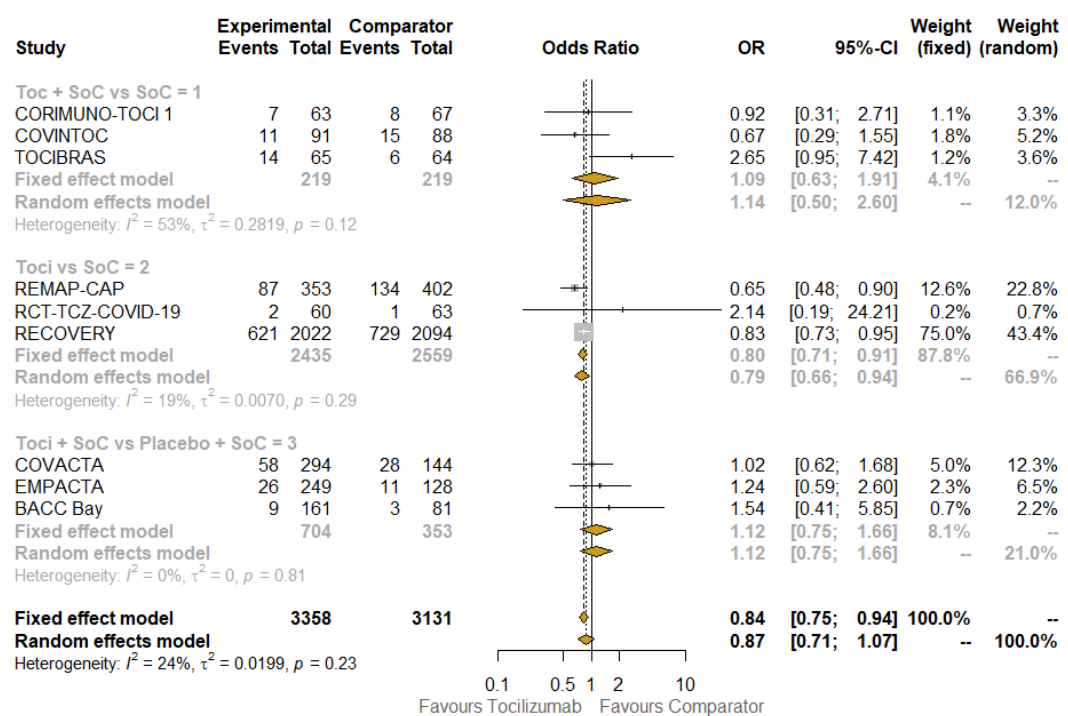
Figure 3. Meta-analysis of 28/30-day mortality in open-label vs. double blind studies. Abbreviations: OR: odds ratio; 95%- CI, confidence intervals at 95%; Weight (fixed), weight of each study in a fixed-effect model; Weight (random), weight of each study in a random-effect model. Squares on the hazard ratio plot are proportional to the weight of each study; weighting is based on the inverse variance method.